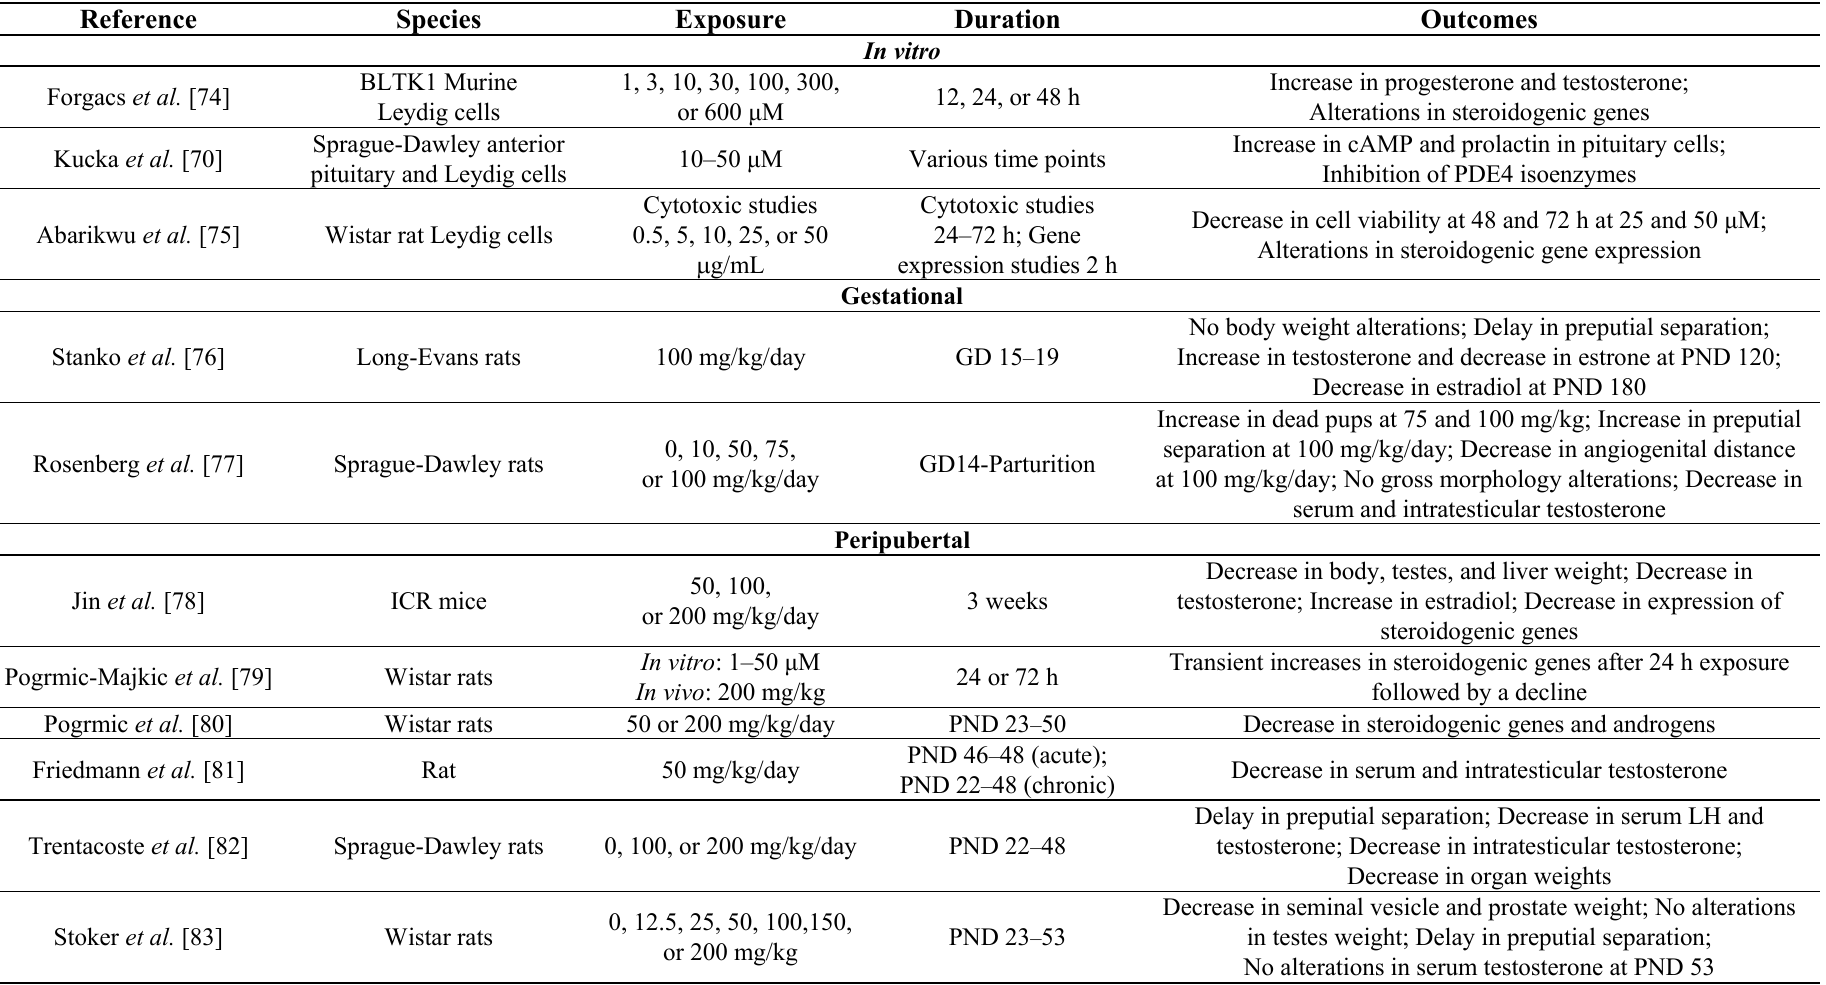
Table 2. Reproductive effects of atrazine in male mammalian